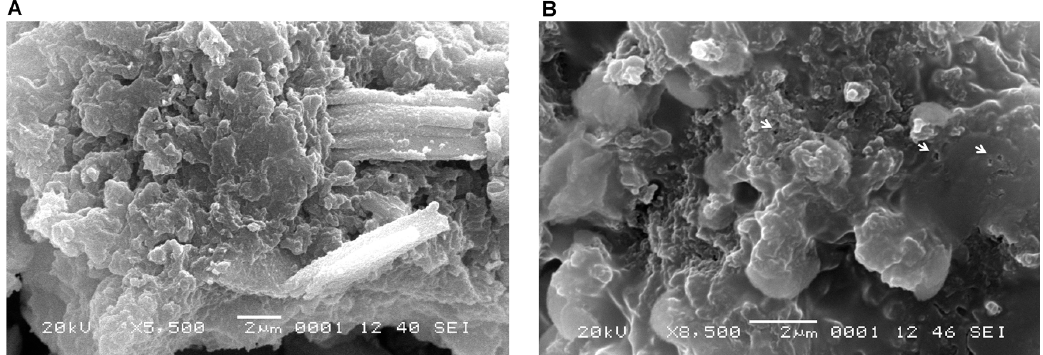
Figure 7. High-magnification SEM images of the latex of ( A ) healthy and ( B ) and PMeV-infected papaya fruits. In the infected latex small circles ranging from 40 to 50 nm, alterations in the structure of the latex and possible latex degradation are evident; these alterations were not observed in healthy latex.